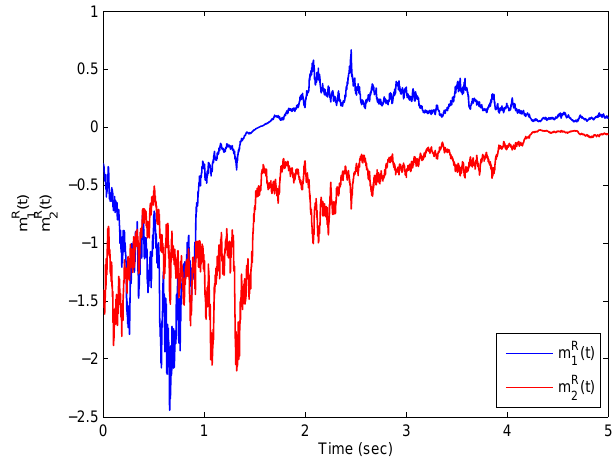
( t ) , m R ( t ) pertaining to the SMQVNN 2 1